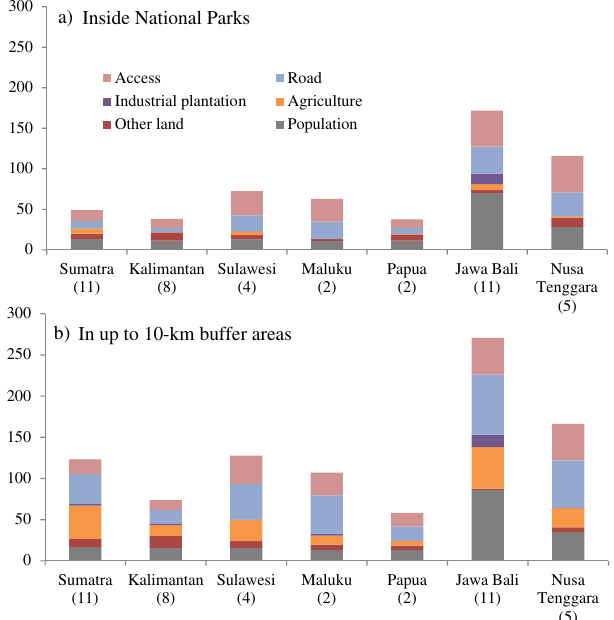
Figure 2. Each Human Footprint pressure per hectare NPs areas in 2017 in 7 bioregions in Indonesia. The numbers below each bioregion are the number of NPs in that